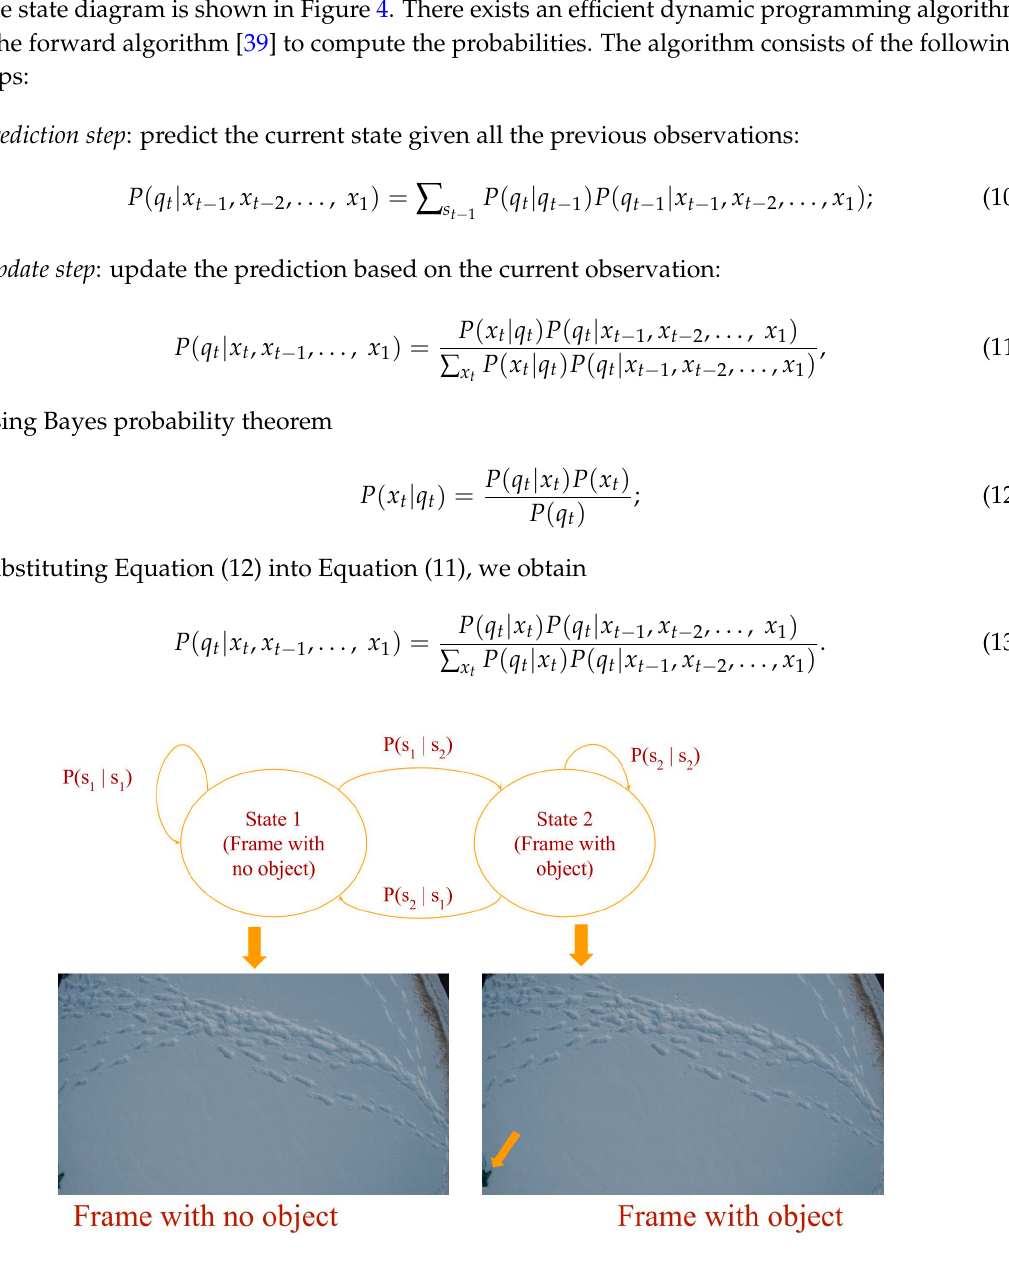
Figure 4. State transition diagram (the object pointed to by a yellow arrow is a jacket used to simulate the top half of a buried victim).